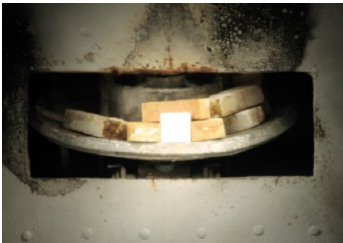
Figure 3. The sample of the material II after exposure to concentrated solar radiation.